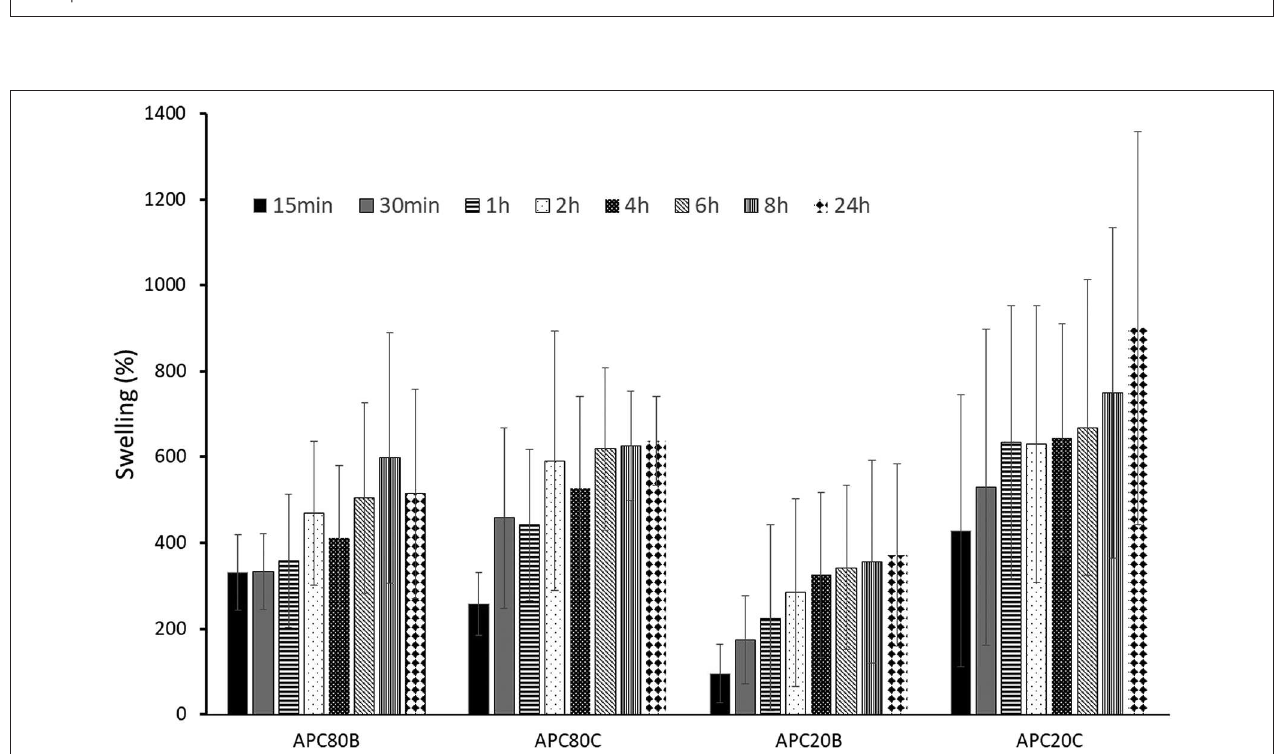
FIGURE 5 | Swelling profiles for APC-based sponges. All samples were immersed in PBS under stirring at 37 ◦ C.